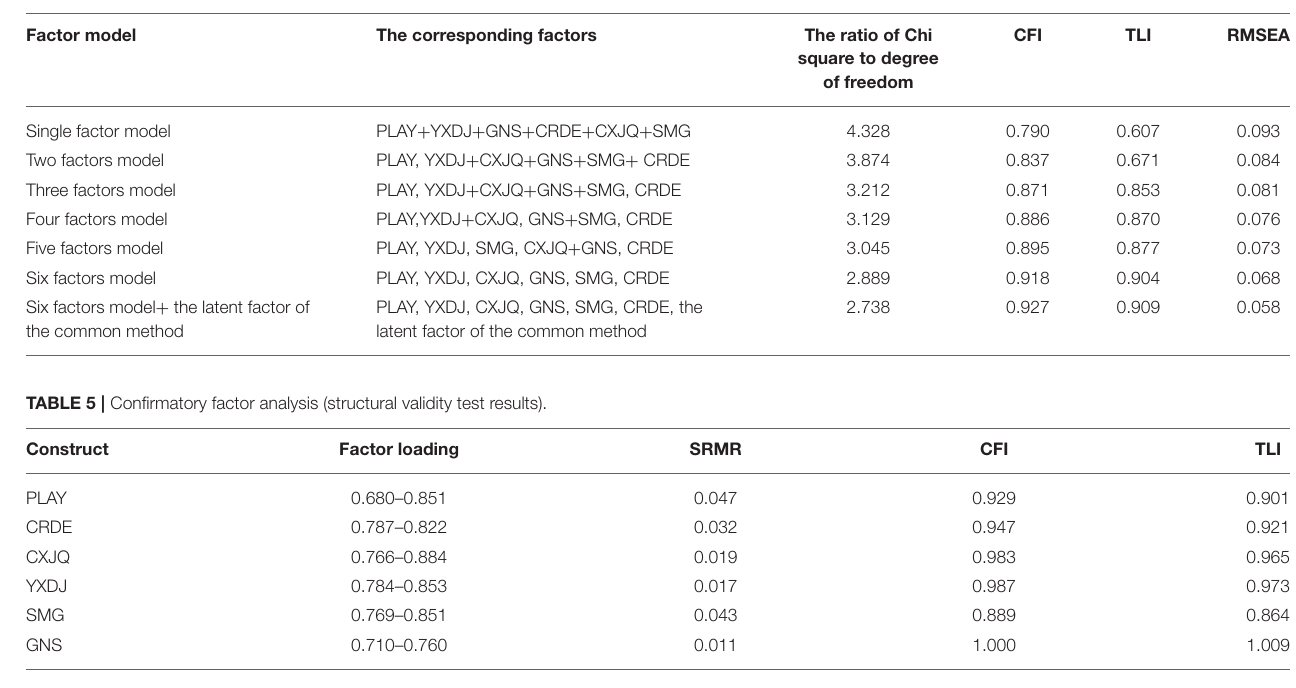
TABLE 4 | Common method bias test results.